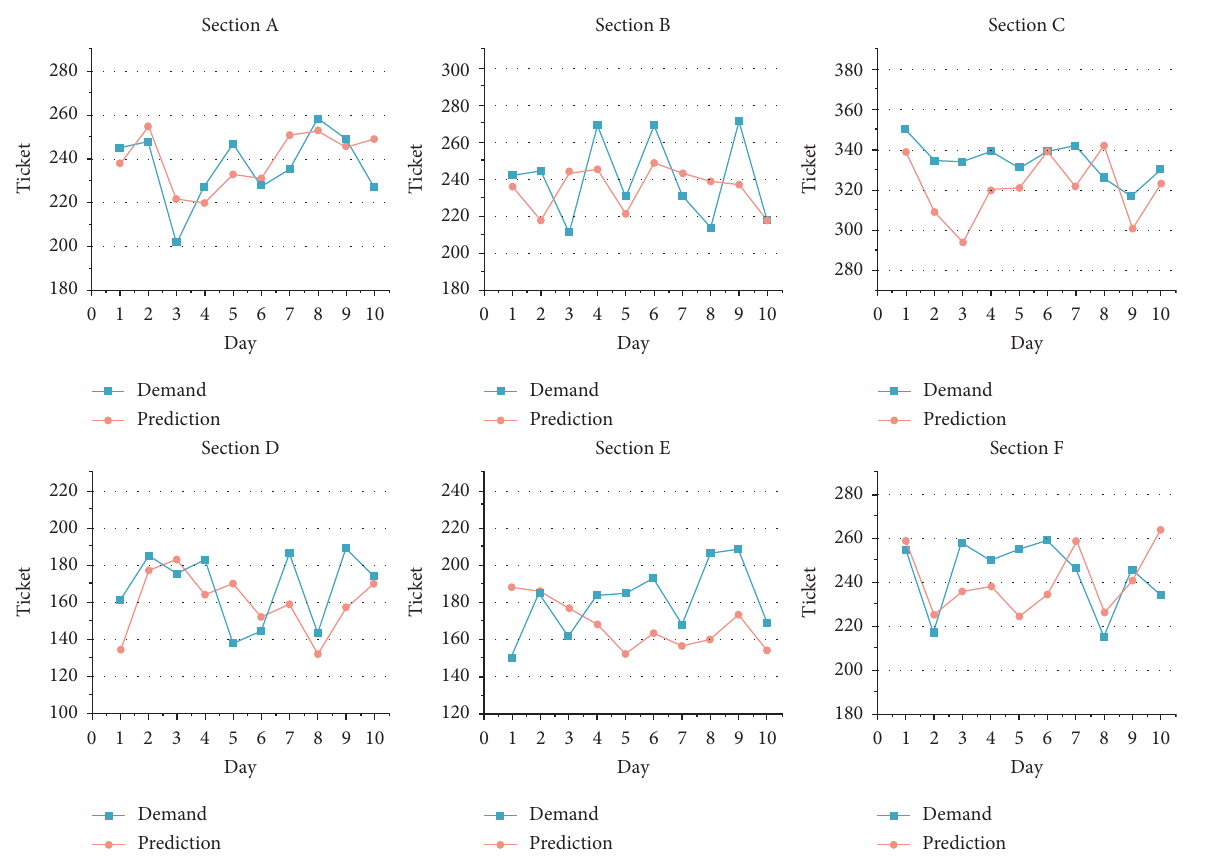
Figure 9: The direct prediction results by GNN.